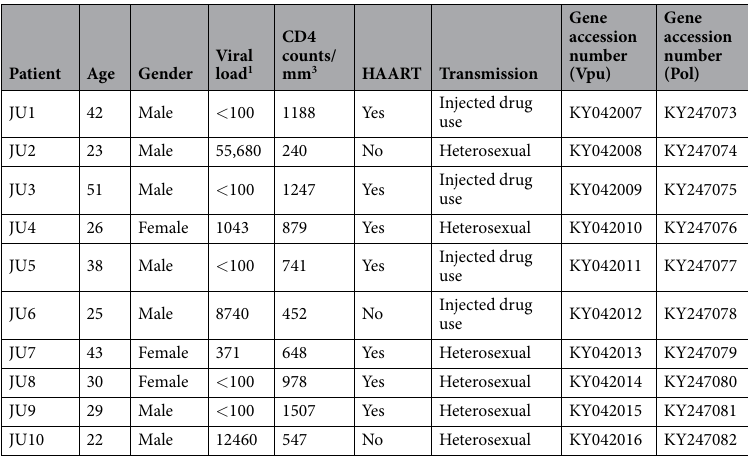
Table 1. Patients’ characteristics. 1 Viral RNA copies per ml peripheral